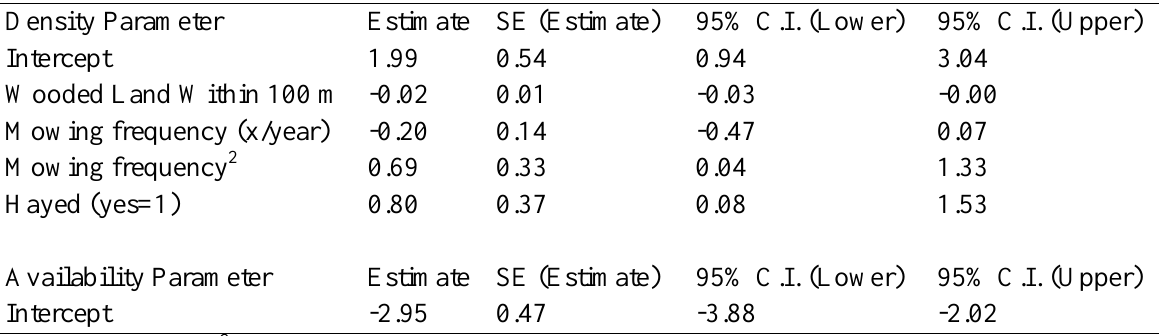
Table A2.A . Highest-ranking hierarchical distance-sampling model (AIC AIC weight=0.34) for Clay-coloured Sparrows along 34 transmission line study sites in Winnipeg, Manitoba, Canada in 2007 (n=102 surveys), assuming a uniform detection probability with increasing distance of birds from the transect line and no effects of Julian date, time of morning, or observer experience on availability for